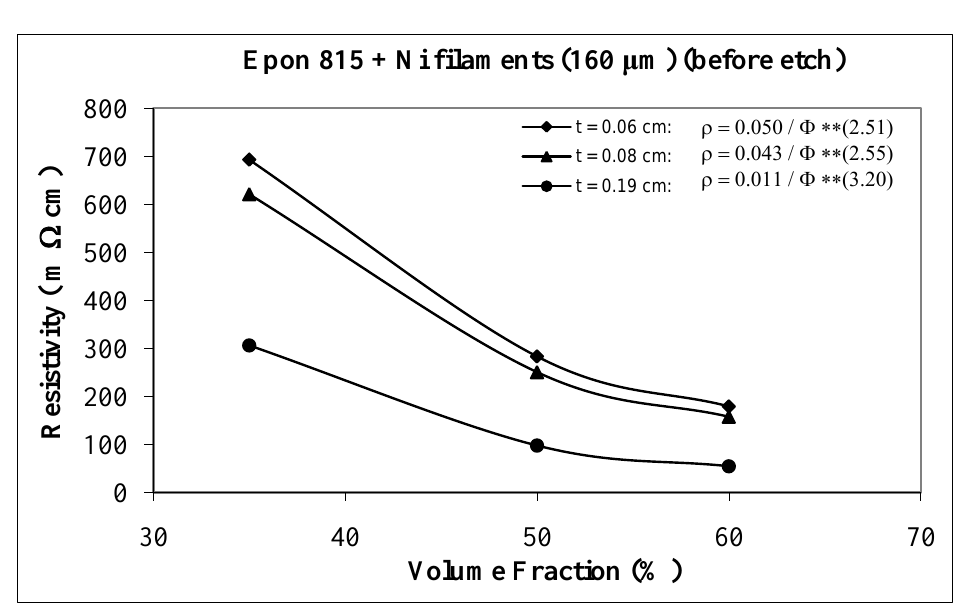
Figure 18. Volume fraction-thickness dependent resistivity of Epon 815C ( a ), and 830 ( b ) films filled with unetched nickel filaments (160 